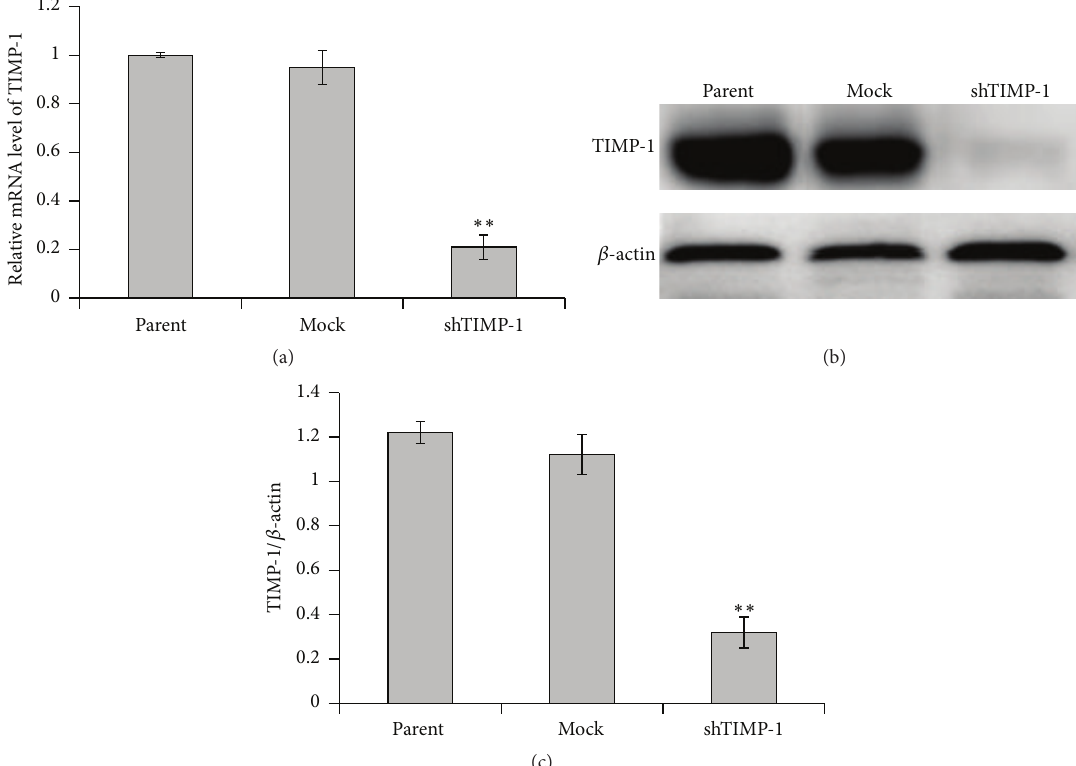
Figure 2: TIMP-1 expression was suppressed by shRNA-TIMP-1. TIMP-1 expression was analyzed by real-time RT-PCR and western blotting, respectively. (a) The levels of TIMP-1 mRNA in parental ADSCs, mock, and shTIMP-1 ADSCs were measured by real-time RT-PCR 72 h after shRNA infection. TIMP-1 mRNA expression in parental ADSCs is defined as 1. The 𝑦 -axis represents the normalized TIMP-1 mRNA expression relative to parental ADSCs. (b) Representative western blot images for the detection of TIMP-1 protein expression in the ADSCs infected with shRNA against TIMP-1. (c) The relative expression level of TIMP-1 protein was quantified by the ratio of optical density of TIMP-1 and 𝛽 -actin. The data are denoted as mean ± SD ( 𝑛 = 3 ). ∗∗ 𝑃 < 0.01 versus mock-shRNA group. Parental ADSCs: uninfected ADSCs; mock ADSCS: control lentivirus infected ADSCs; shTIMP-1 ADSCs: shRNA-TIMP-1 lentivirus infected ADSCs.